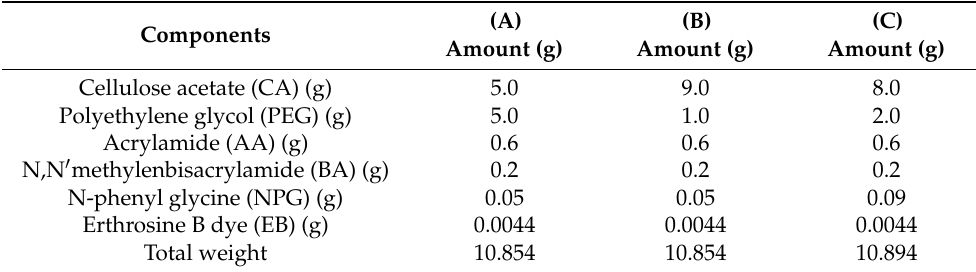
Table 1. The amount of components added in the photopolymer solution (prepared in acetone 100 mL).